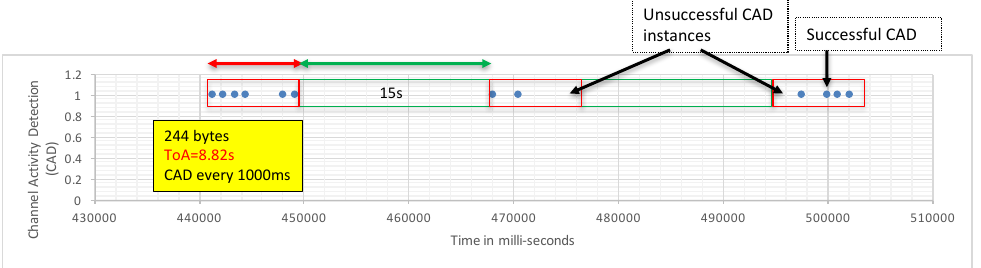
Figure 4. CAD fails to detect activity of on-going